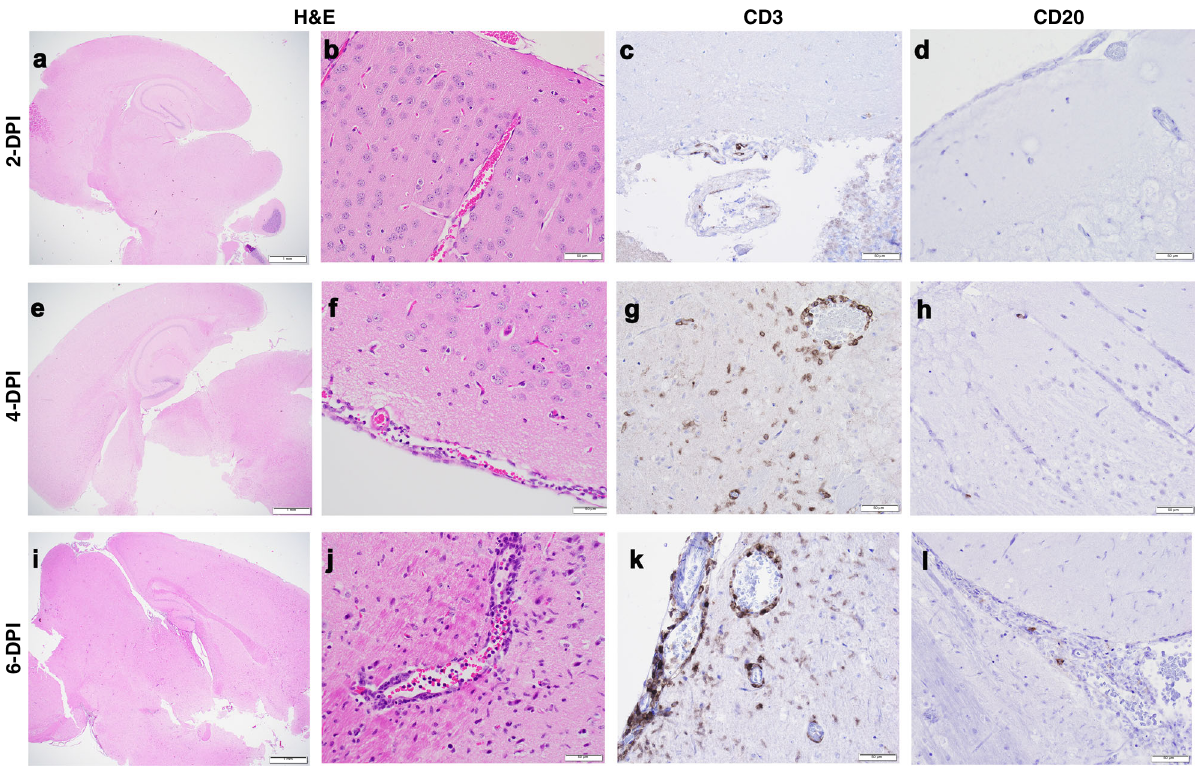
Fig. 7 T- and B-cell accumulation in brain of SARS-CoV-2-infected K18 hACE2 transgenic mice. Normal brain shown at 2 DPI ( a , b ). Incremental mononuclear in fi ltrates were noted histologically at 4 ( e , f ) and 6 ( i , j ) DPI. There was CD3 cytoplasmic immunolabeling of rare round cells morphologically consistent with lymphocytes in the brain 2 DPI ( c ). Incremental meningeal, intra-parenchymal, and perivascular CD3-positive cells were observed in the brain of 4 ( g ) and 6 ( k ) DPI. Brain of 2 ( d ) and 4 ( h ) DPI were mostly negative for CD20. CD20-positive cells were rare at 6 DPI ( l ). The outer margins of vascular structures and in some occasions the collagenous connective tissue of the meninges exhibited non-speci fi c staining. The brain of 2 and 4 DPI mice had rare individual intra-parenchymal CD3 cells, some of which were not morphologically consistent with round cells. Tissue time points and staining as Fig. 6. Representative images of n = 6 (three males and three females per time-point and group) randomly chosen. Scale bars left images, 1 mm. Scale bars right images, 50 μ m. Data are representative over two independent experiments. Table 3 T- and B-cell evaluation of SARS-CoV-2-infected K18 hACE2 transgenic C57BL/6 mice in lung and brain and severity